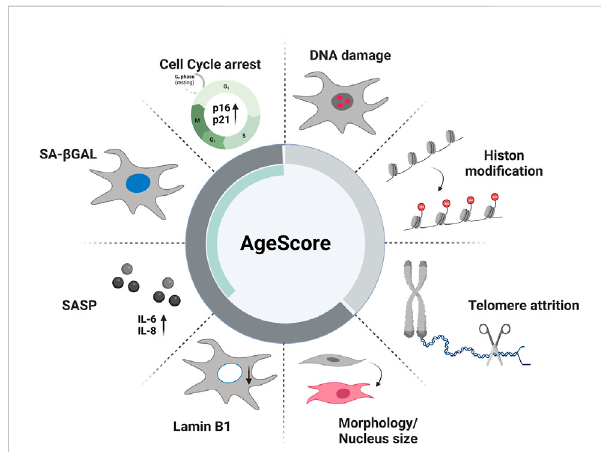
FIGURE 1 Age markers of proposed AgeScore. The here proposed panel contains the following age markers: primary aging markers (DNA damage, Histone modi fi cation, telomere attrition) and antagonistic aging markers (cell cycle arrest, senescence-associated β Galactosidase (SA- β GAL), senescence-associated